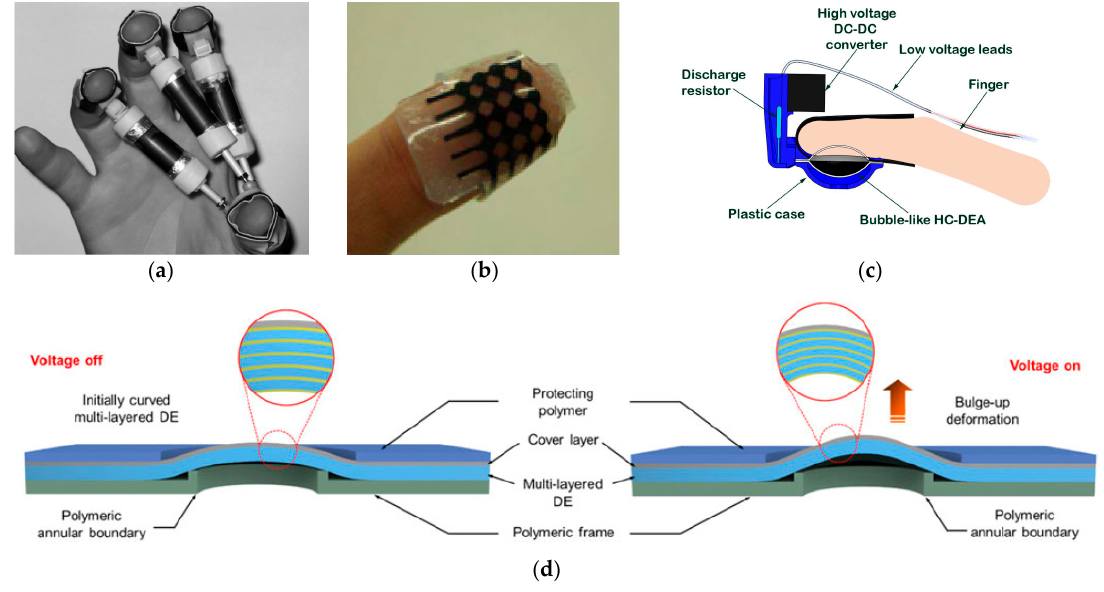
Figure 12. Wearable interfaces using DEAs: ( a ) force feedback system using roll DEA [120]; ( b ) soft tactile display using DEA [121]; ( c ) tactile display using HC-DEAs [124]; ( d ) stacked DEA with polymeric frame to maintain curvature [126].